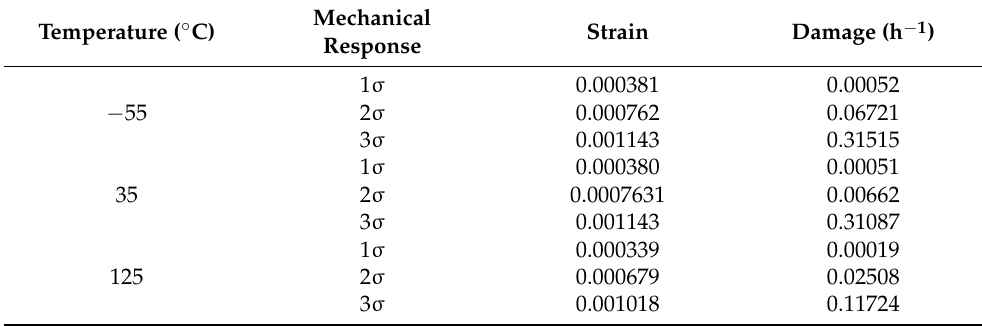
Table 11. The mechanical response of the dangerous node under the combined temperature cycling and random vibration.